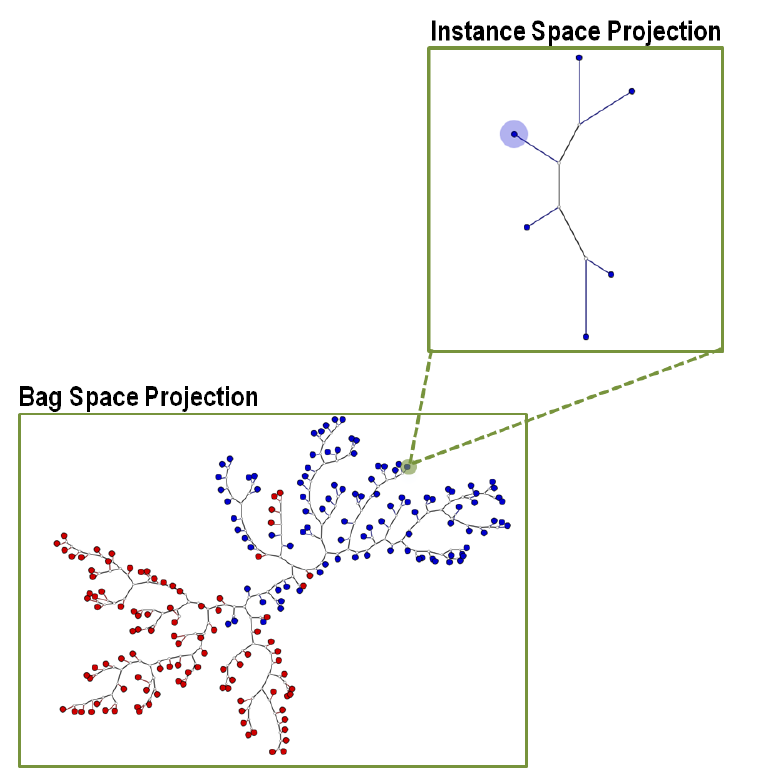
Figure 1. Layouts of Bag and Instance Spaces for the Corel-1000 subset (with instance prototypes highlighted) in the MILTree, with a total of 200 bags and 824